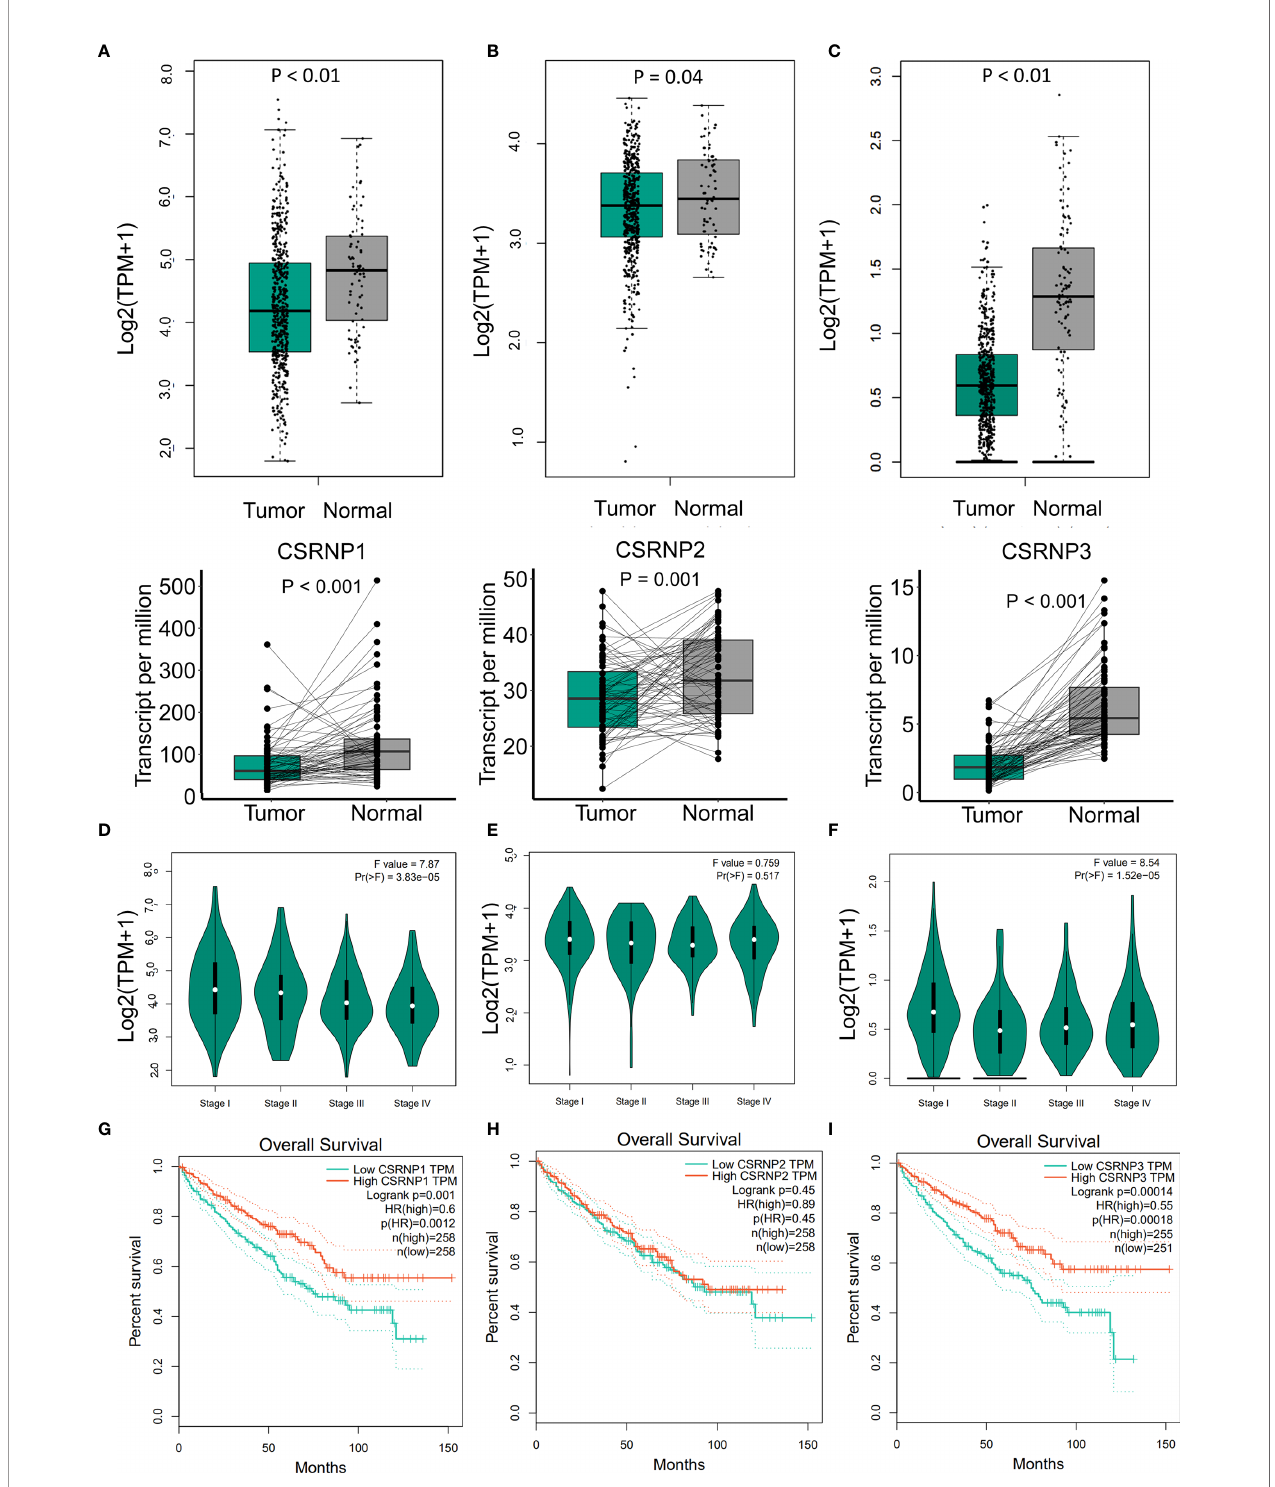
FIGURE 1 | mRNA expression, stage-speci fi c expression, and overall survival of CSRNP gene family members according to GEPIA. (A – C) mRNA expression of CSRNP family members in tumor and normal tissues (upper image), and paired tumor and normal tissues (lower image). Green: tumor tissues; gray: normal tissues. (D – F) Stage-speci fi c mRNA expression of CSRNP family members. (G – I) Kaplan-Meier curves of the overall survival analysis in relation to the CSRNP